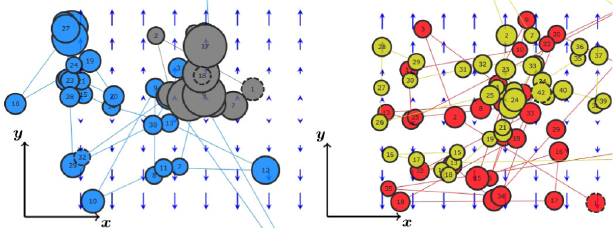
FIG. 7. Gaze plots of the two best performing students (left) and of two worst performing students (right). In both cases, students applied the differential strategy to vector field V1.